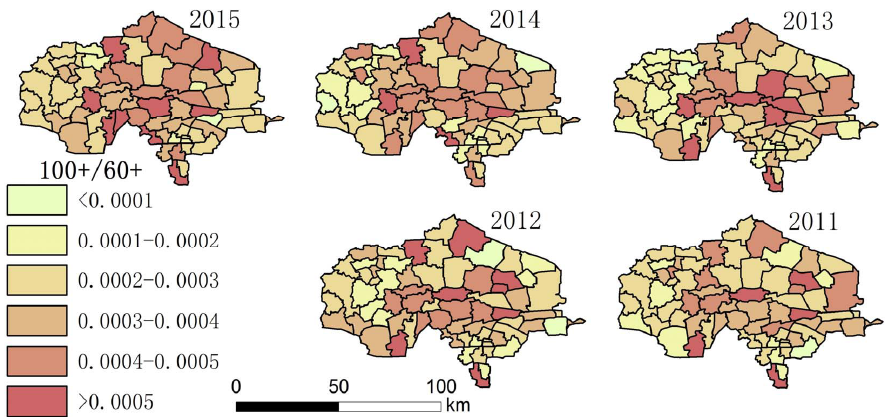
Figure 6. The proportion the aging population of each town made up of people over